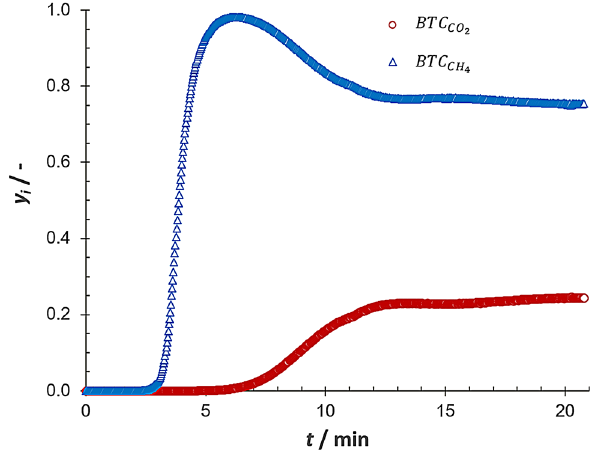
O with CO (red) 2 3 2 Fig. 13 Breakthrough curve (BTC) of a binary CH = 0.25) at T = 303.15 K, p = 5 bar and a flow rate of 50 mL min −1 (STP) on a fixed bed ( L bed = 15 cm, d bed = 1.5 cm) of Ni-MOF-74@Al core–shell